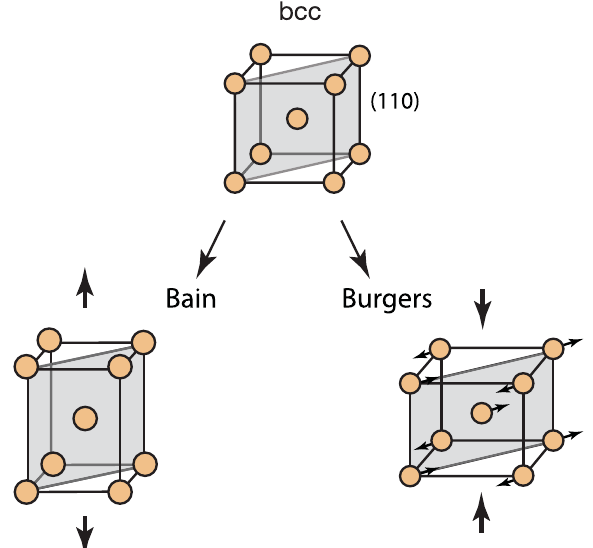
Fig. 6 The Bain and Burgers paths. The bcc crystal can be converted to fcc through a tetragonal strain known as the Bain path 19 or it can be converted to hcp along the Burgers path, which combines a compressive tetragonal strain with an atomic shuf fl e 20